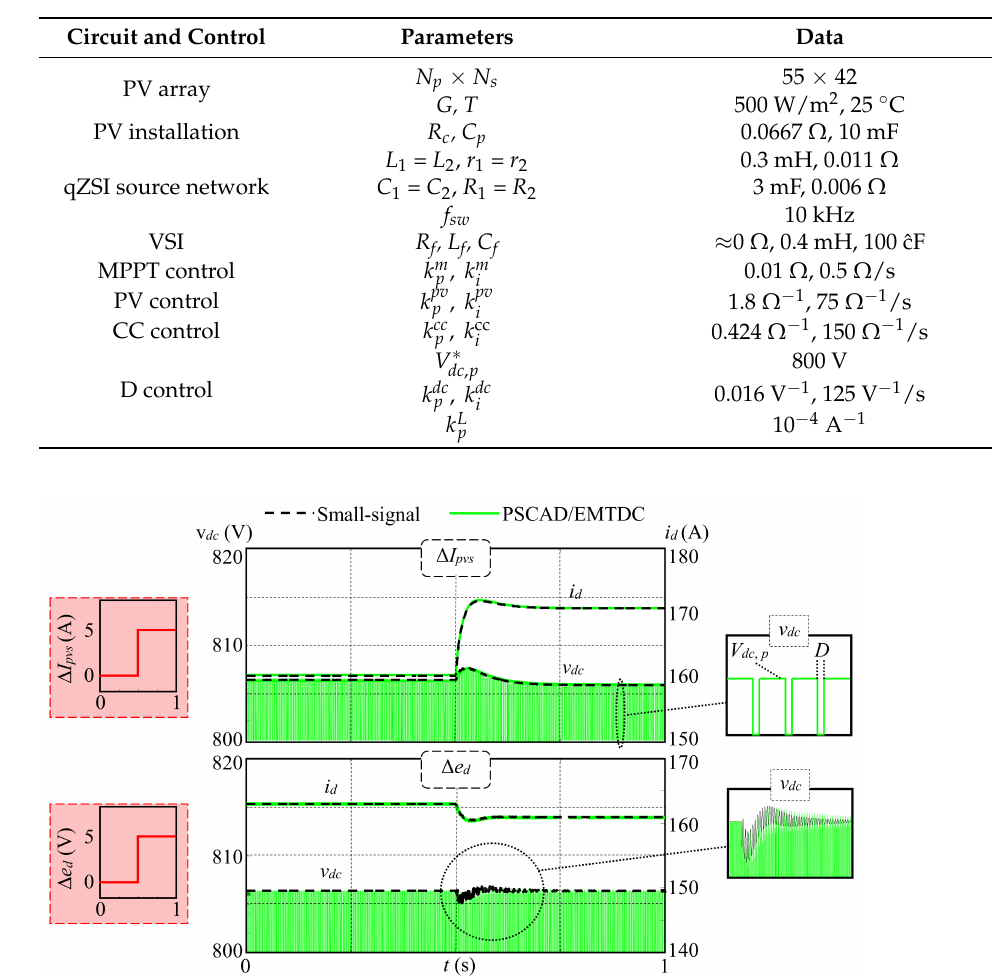
Table 1. The qZSI-based PV power system parameters.